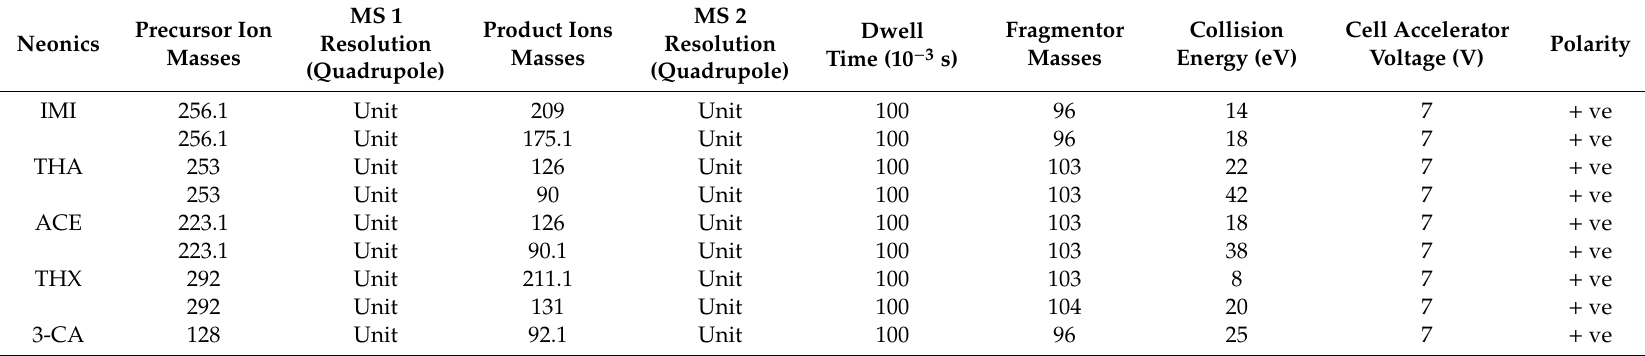
Table 2. Multiple reaction parameters for the developed LC / MS / MS method. (IMI = Imidacloprid; THA = Thiacloprid; ACE = Acetamiprid; THX = Thiamethoxam; and 3-CA =